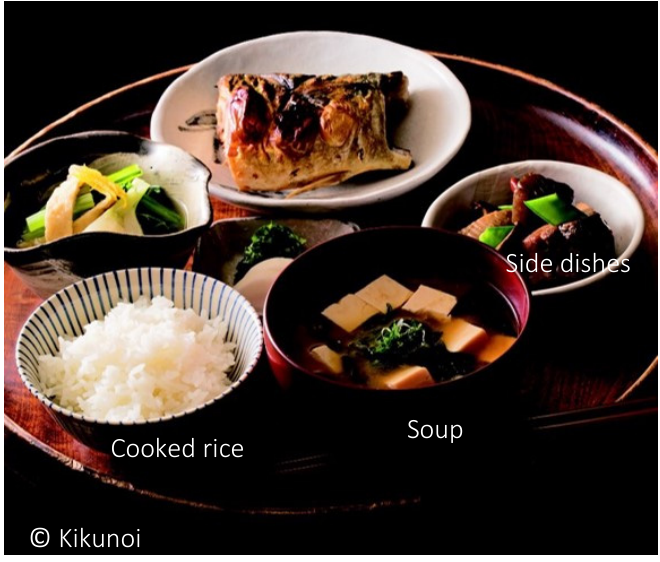
Figure 1. The basic structure of Washoku, comprised of one soup, cooked rice, and three side dishes, deliciously prepared with dashi stock as accompaniment for the rice. Table 1. Characteristic dishes and ingredients of the Japanese traditional diet.